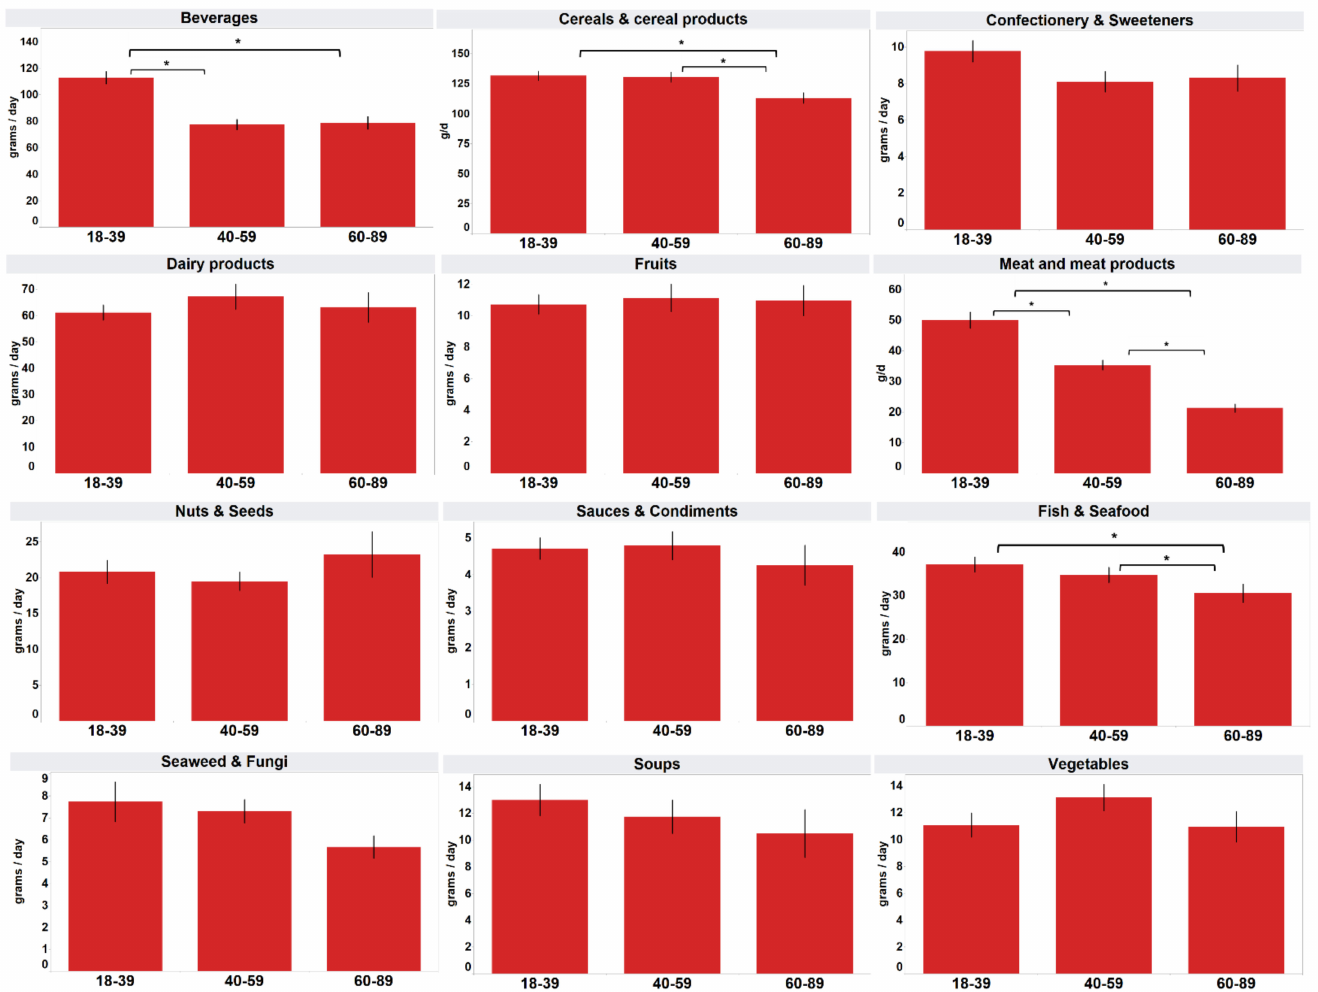
Figure 3. Mean daily intake of consumers analysed by age group. * Mean values were significantly different as determined by ANOVA with Tukey’s HSD test for multiple comparisons ( p < 0.05). The respondents residing in Terrace/Semi-Detached/Bungalow and Condominiums/ Private Apartments consumed significantly more “dairy products” (mean 95.4 g, 83.6 g) than those living in HDB 1–3 Room (mean 59.2 g) and HDB 4–5 Room (mean 60.2 g) ( p < 0.05) (Figure 4). The residents of Terrace/Semi-Detached/Bungalow (mean 33.2 g) also consumed significantly more processed “nuts and seeds” than the residents of HDB 1–3 Room (mean 18.0 g), HDB 4–5 Room (mean 20.8 g) and Condominiums/Private Apartments (mean 18.4 g) ( p <